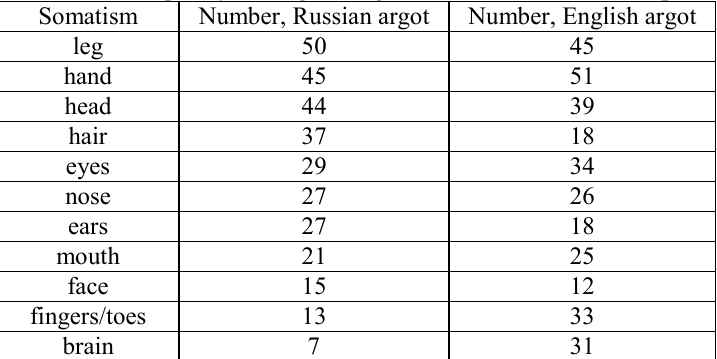
Table 1 – Frequency of usage of argotic units with somatic